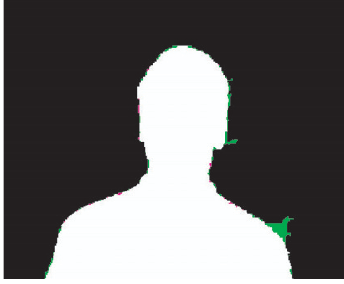
Figure 13: The colored segmentation error of frame 15 from the sequence “Erik,” segmented using COST AM 5.0.